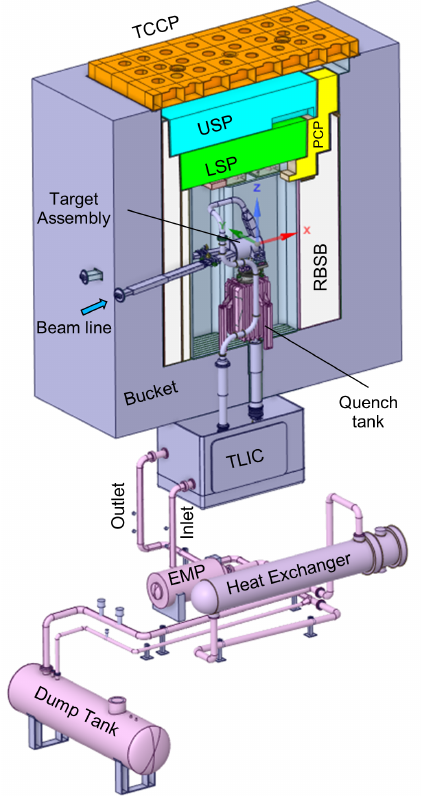
Figure 1. Test Cell and lithium loop of IFMIF-DONES with the space reservation of the